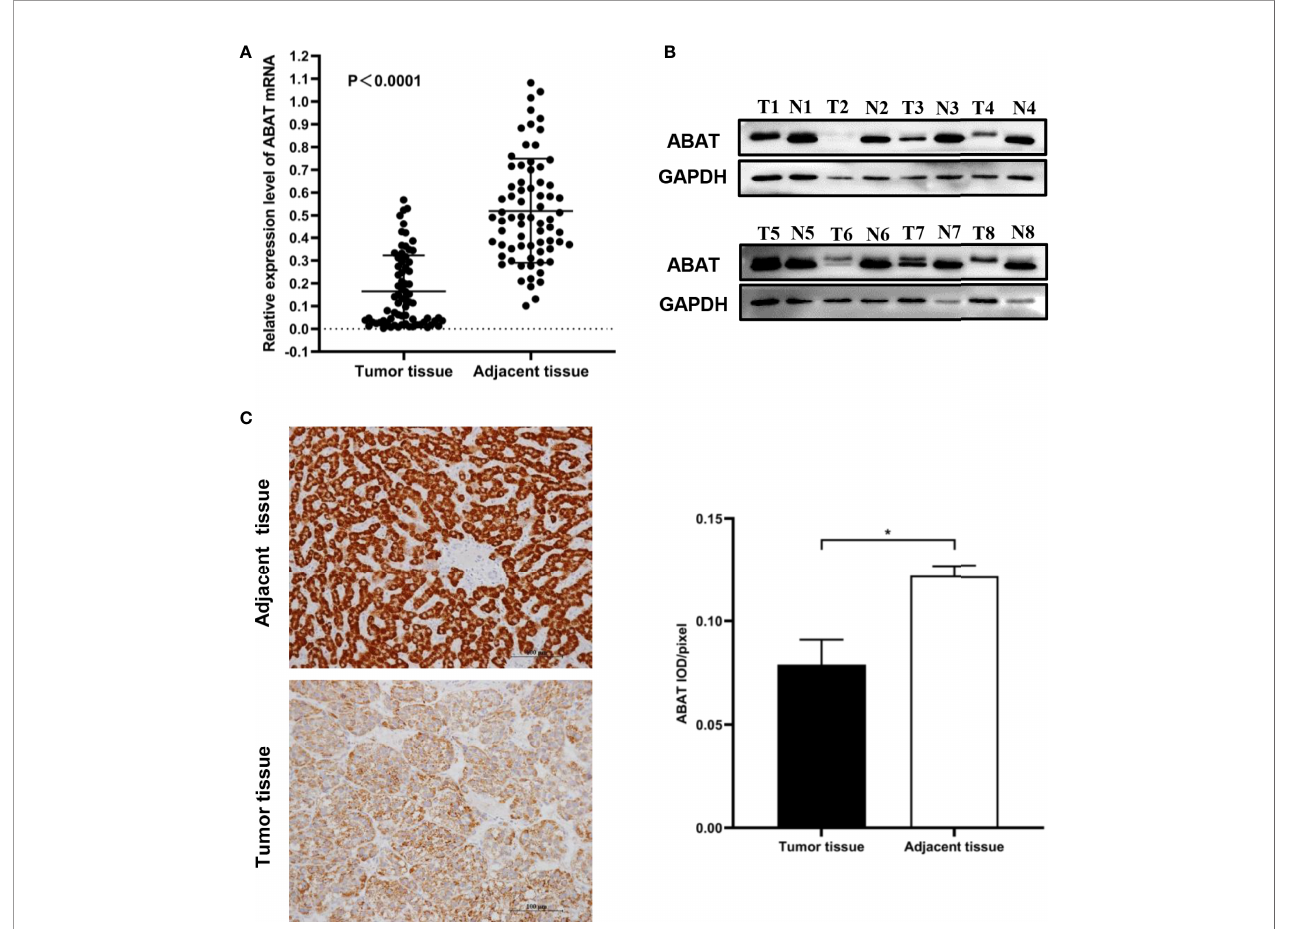
FIGURE 2 | Expression of ABAT in HCC. (A) qRT-PCR (P < 0.0001), (B) Western blot, and (C) IHC all showed that ABAT expression was lower in HCC tissues than in adjacent tissues. *P <